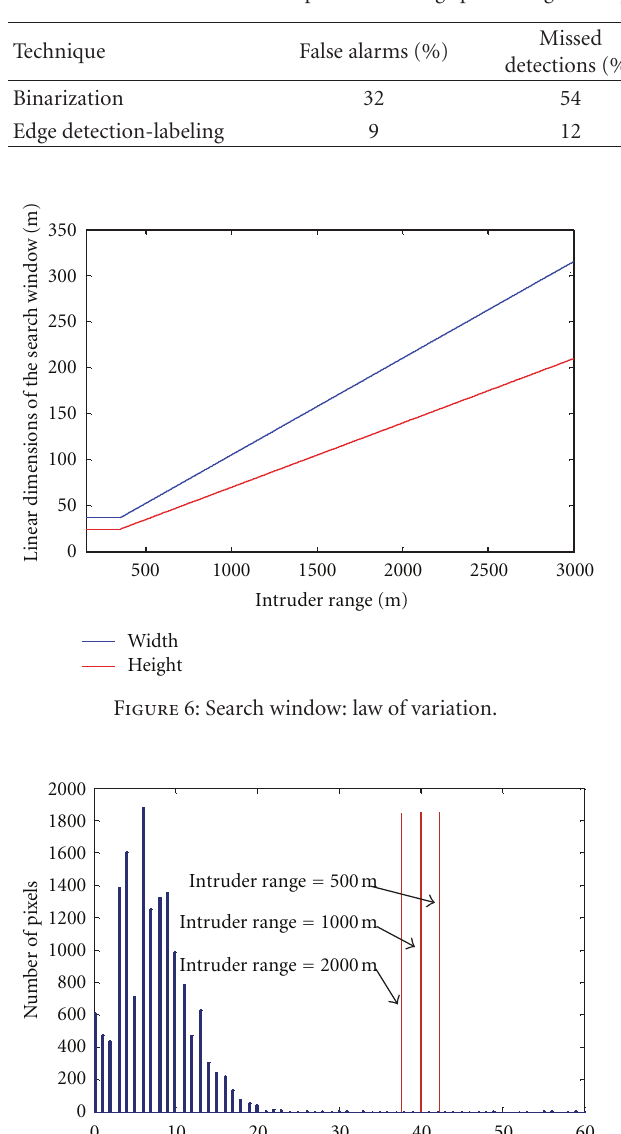
Figure 5: (a) Output of the image processing technique applied on the search window; (b) intruder aircraft detected at 2400 m. Table 1: Performance comparison of image processing techniques relevant to frontal encounters carried out during flight tests.